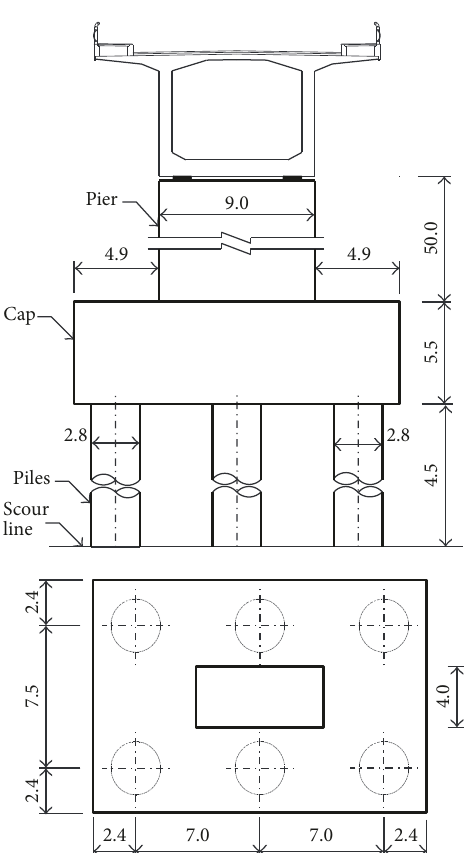
Figure 3: Dimensions of the prototype slender bridge pier; all dimensions are in